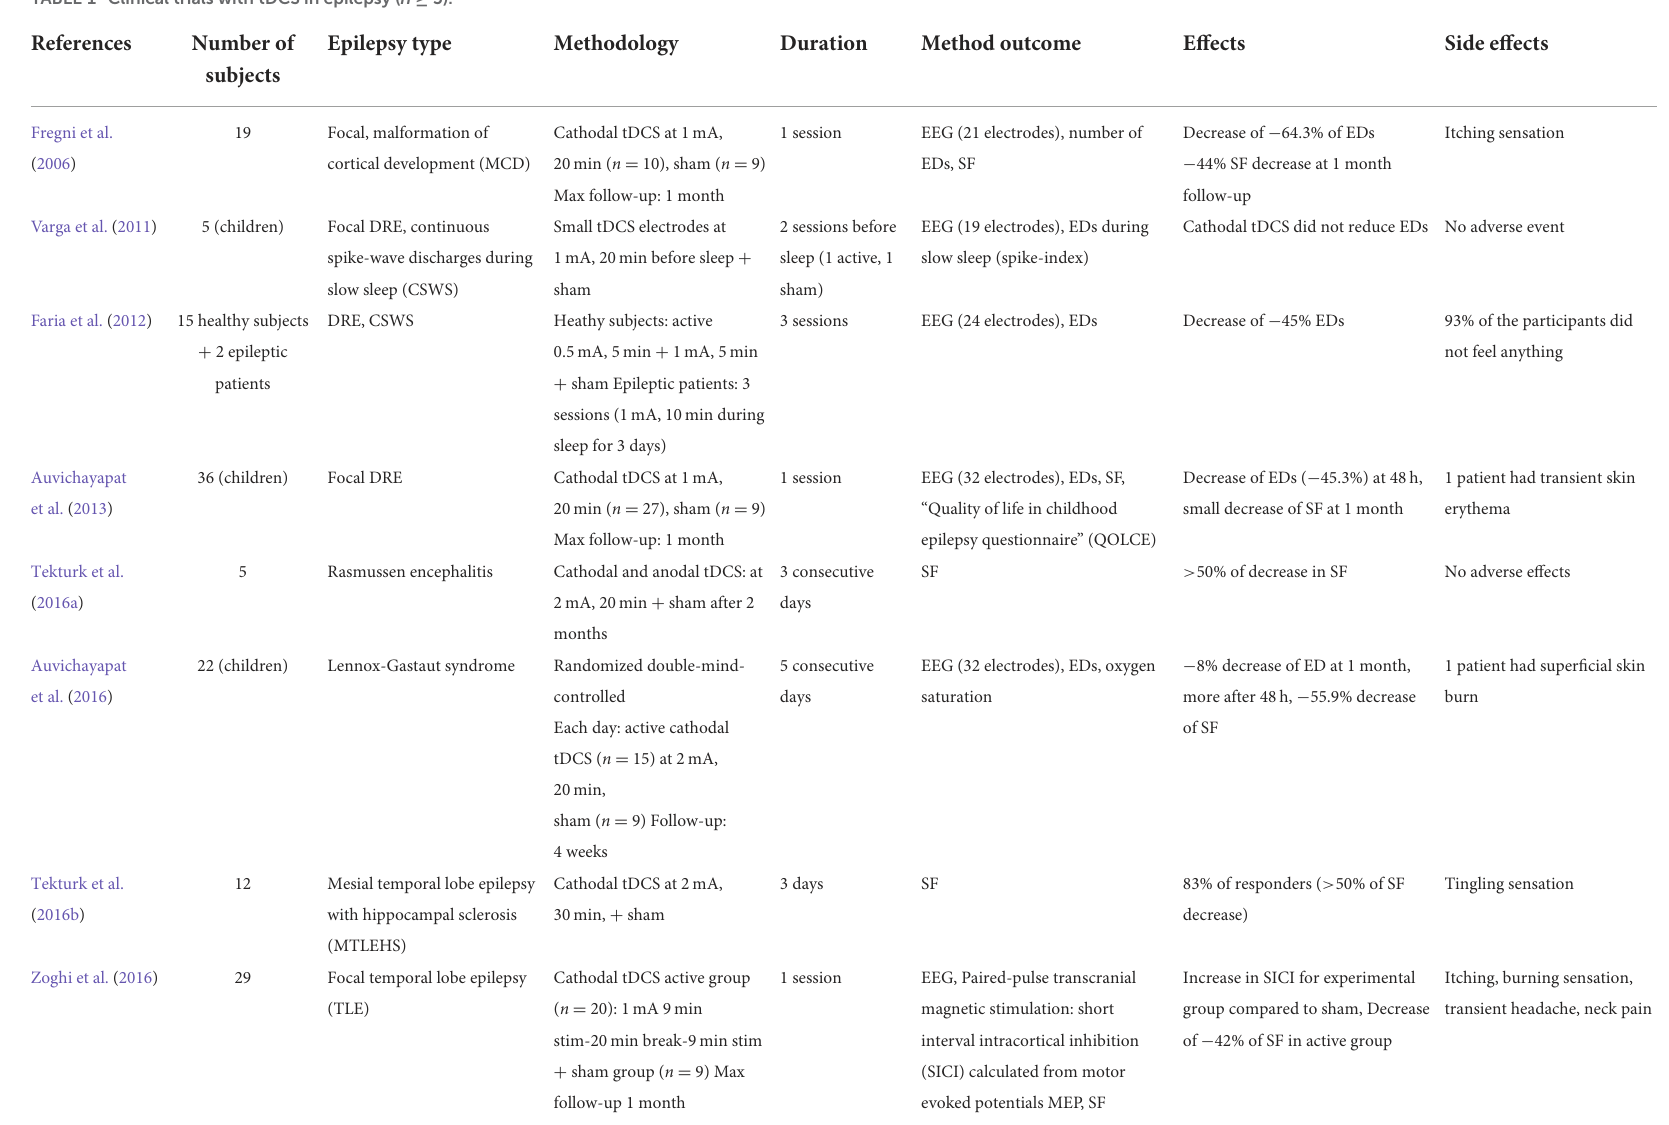
TABLE 1 Clinical trials with tDCS in epilepsy ( n ≥